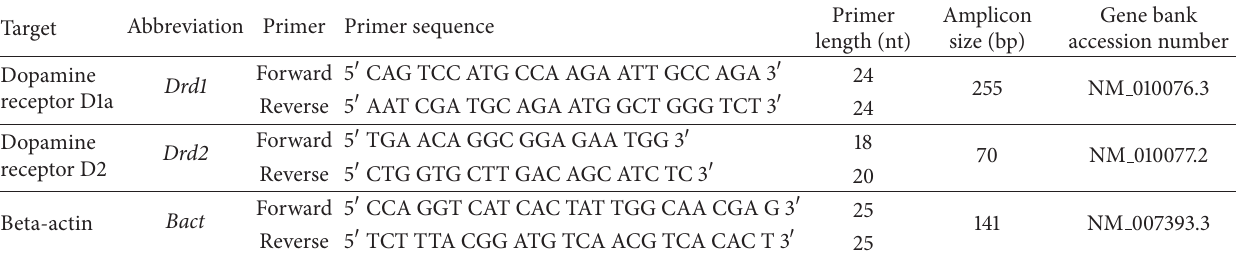
Table 1: Primer sets used for SYBR green-based qPCR analysis of dopamine